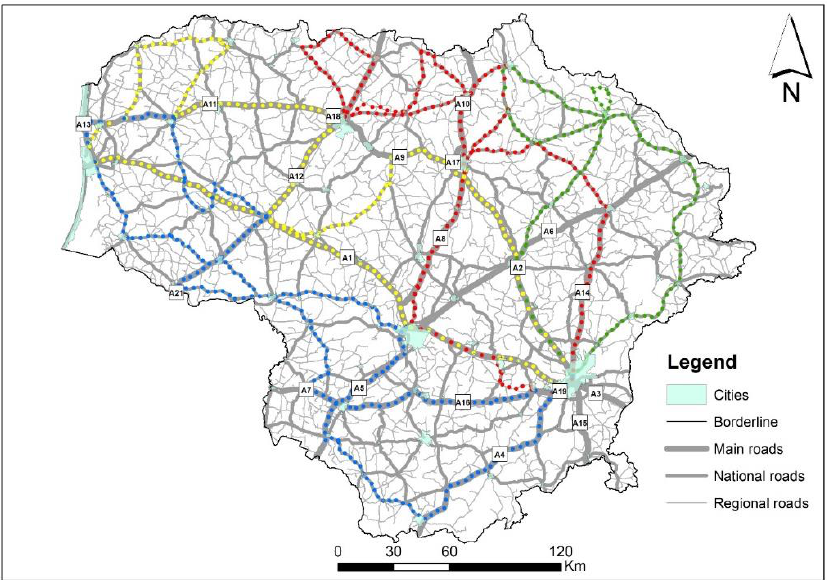
Figure 7. Proposed routes for raccoon dog roadkill monitoring in Lithuania, each designated by a different